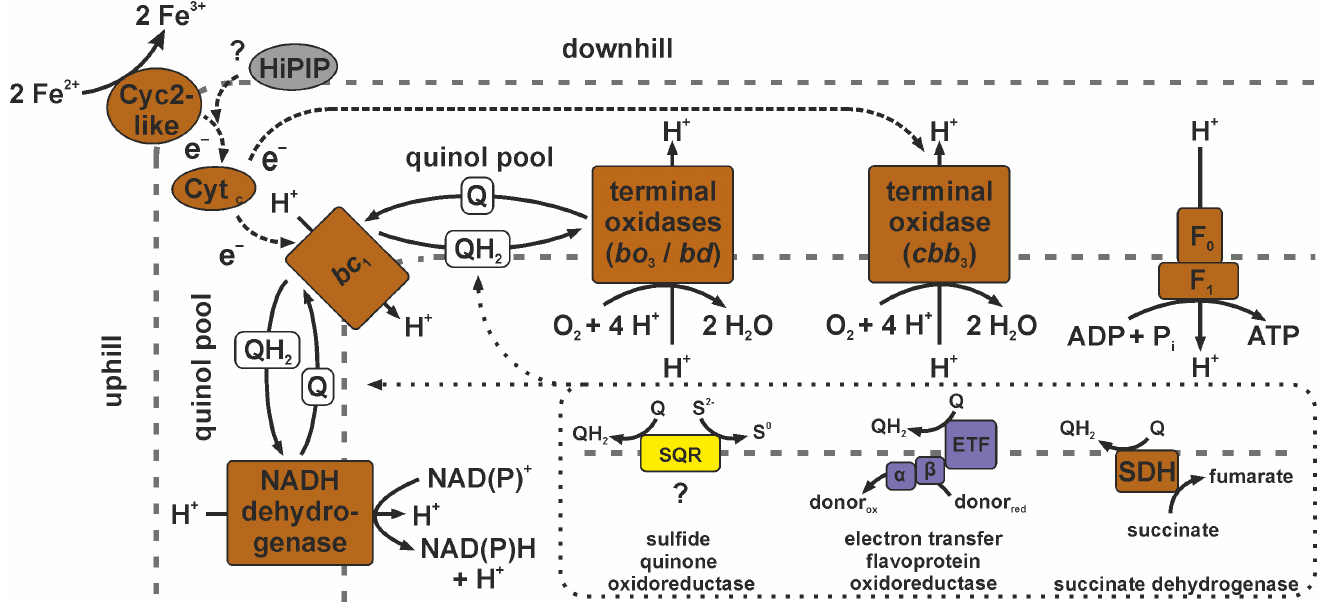
Fig 4. Predicted electron transfer from ferrous iron to the terminal electron acceptors in “ Ferrovum ” strain JA12. Ferrous iron is probably oxidised at the cell surface by a high molecular mass cytochrome (Cyc2-like). The relevance of the identified high potential iron-sulfur protein (HiPIP) in this process remains unknown. The electrons appear to be further transferred via soluble c -type cytochromes in the periplasm either uphill driven by the proton motive force to the bc 1 complex and NADH dehydrogenase to produce reduction equivalents (NAD(P)H), or downhill via the cbb 3 -type cytochrome c oxidase or alternatively via one of the quinol oxidases (cytochrome bd complex, cytochrome bo 3 ubiquinol oxidase) to the terminal acceptor oxygen. The reduction of oxygen to water at the terminal oxidases neutralises protons entering the cell during ATP synthesis via the ATP synthase (F 0 F 1 ). The terminal oxidases bo 3 and cbb 3 pump protons into the periplasm driven by the downhill electron transfer to oxygen. Since the identity of the quinol derivates produced by “ Ferrovum ” strain JA12 was not investigated QH 2 represents the reduced form and Q the oxidised form of the quinol derivative, respectively. The genome also encodes other potential oxidoreductases which could channel electrons into the quinol pool (e.g. sulfide quinone oxidoreductase (SQR), electron transfer flavoprotein oxidoreductase (ETF), succinate dehydrogenase (SDH) of the citrate cycle).